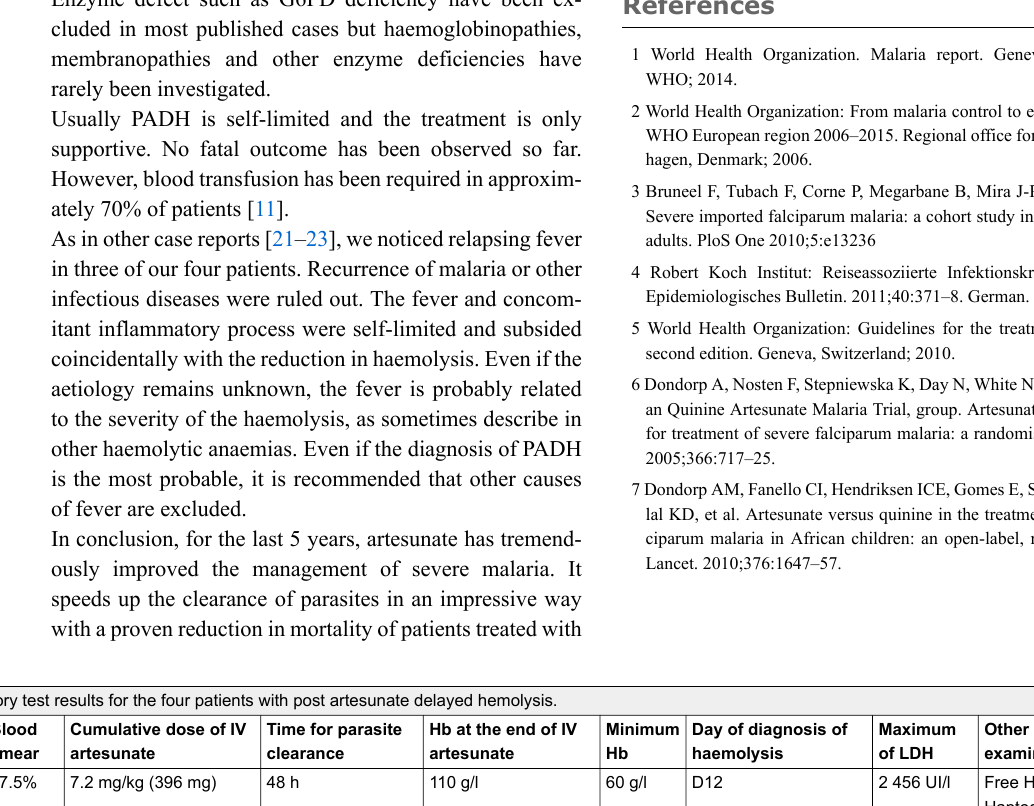
Time for parasite clearance